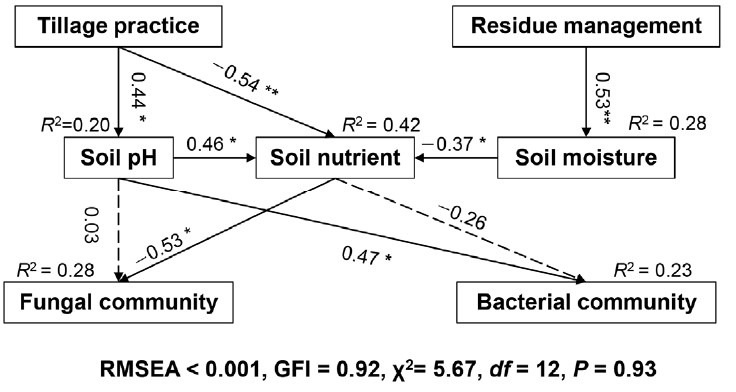
Figure 2. Structural equation models (SEMs) showing the direct and indirect effects of tillage practices and residue retention on soil bacterial and fungal community composition. Values above the line represent the path coefficients. Solid and dashed lines indicate significant and non-significant pathways, respectively (** p < 0.01; * p < 0.05). Table 1. Mantel tests of the soil bacterial and fungal communities’ compositions with soil variables in 2017 and 2018.